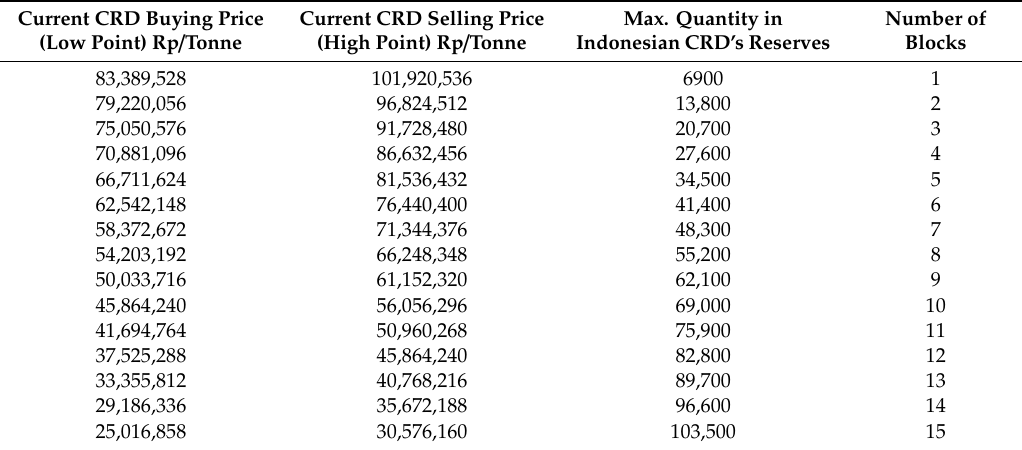
Table 1. Illustrative Rupiah Price-Schedule for